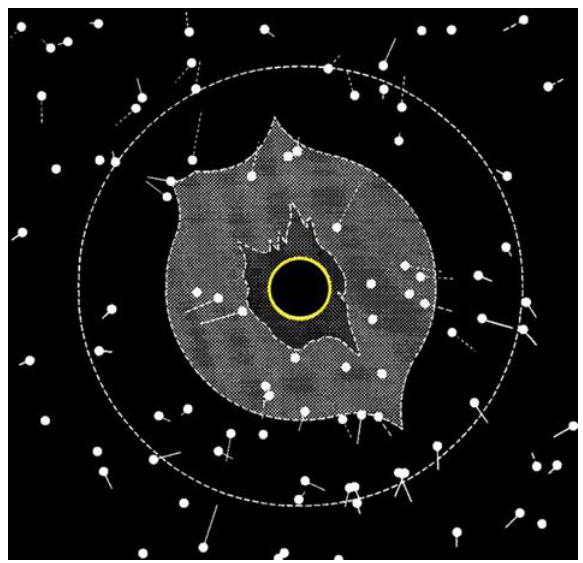
Figure 4. Changes in star positions recorded during the eclipse of 1922 and published in Campbell & Table 1923. Figure modified after ref. [39].